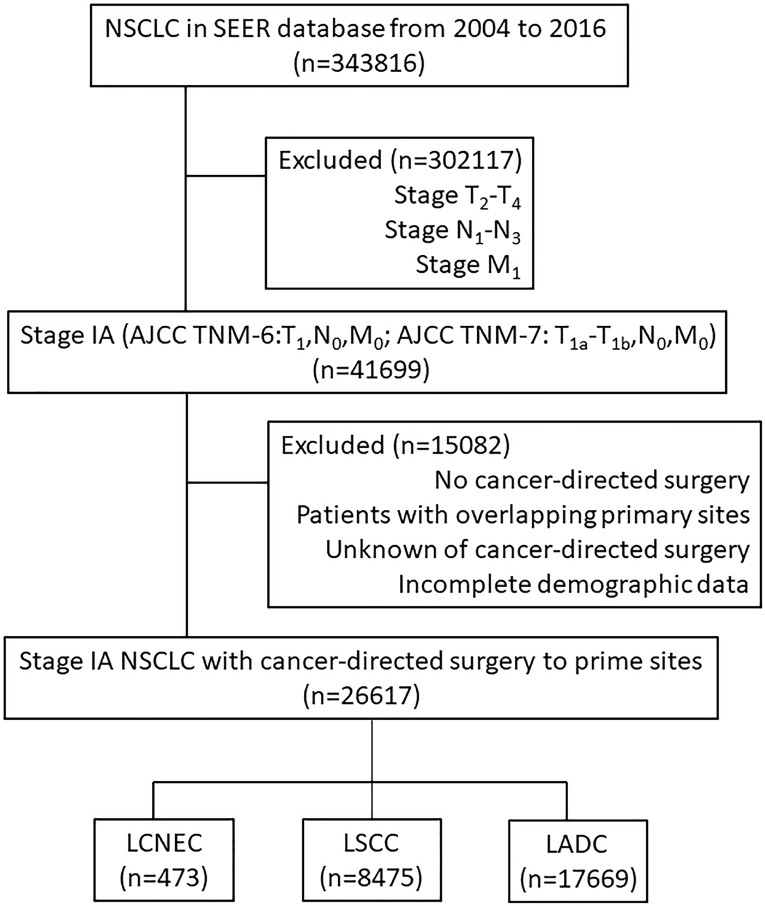
Flow diagram of enrollment. NSCLC, non-small cell lung cancer; the SEER database, Surveillance Epidemiology, and End Results database; AJCC, American Joint Committee on Cancer staging system; LCNEC, large cell neuroendocrine carcinoma; LSCC, lung squamous cell cancer; LADC, lung adenocarcinoma.